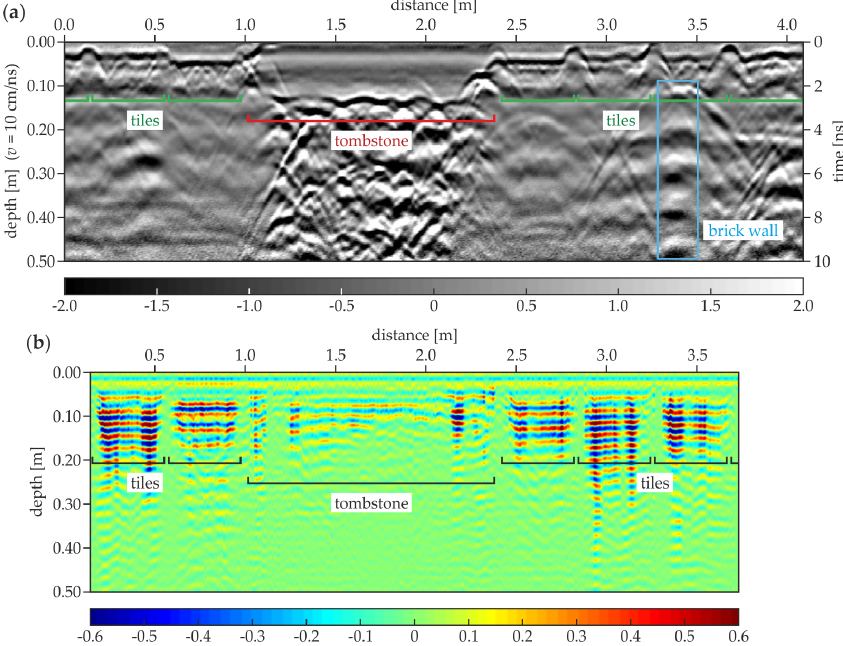
Figure 18. GPR and UT B ‐ scans for trace A ‐ 121 (south aisle): ( a ) GPR scan; ( b ) UT scan.